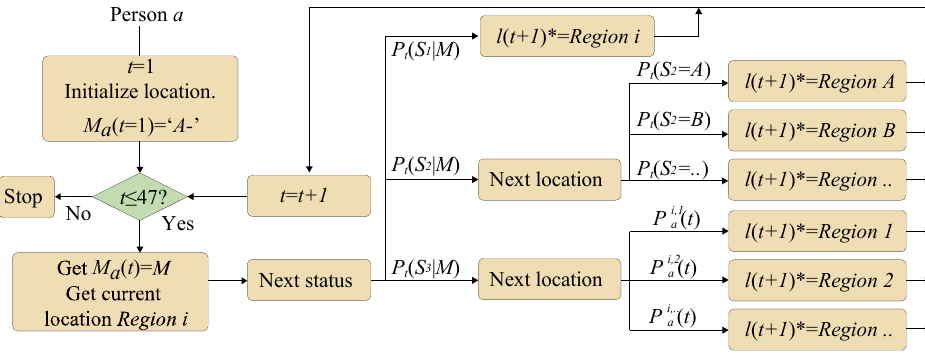
Figure 8. Flowchart of reproducing human mobility.